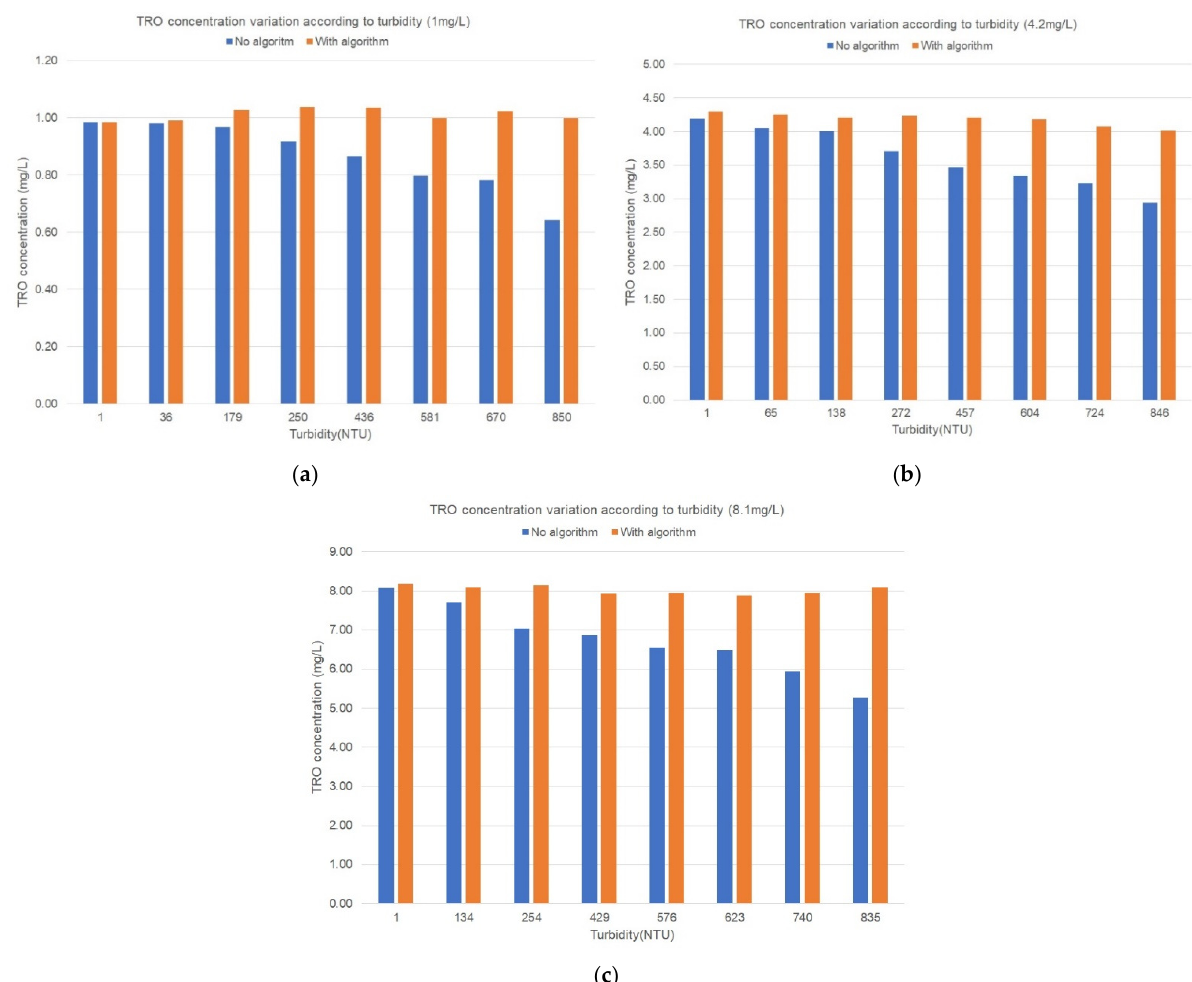
Figure 14. TRO concentration with or without algorithm according to variation in turbidity: ( a ) 1 mg/L; ( b ) 4.2 mg/L; ( c ) 8.1 mg/L.